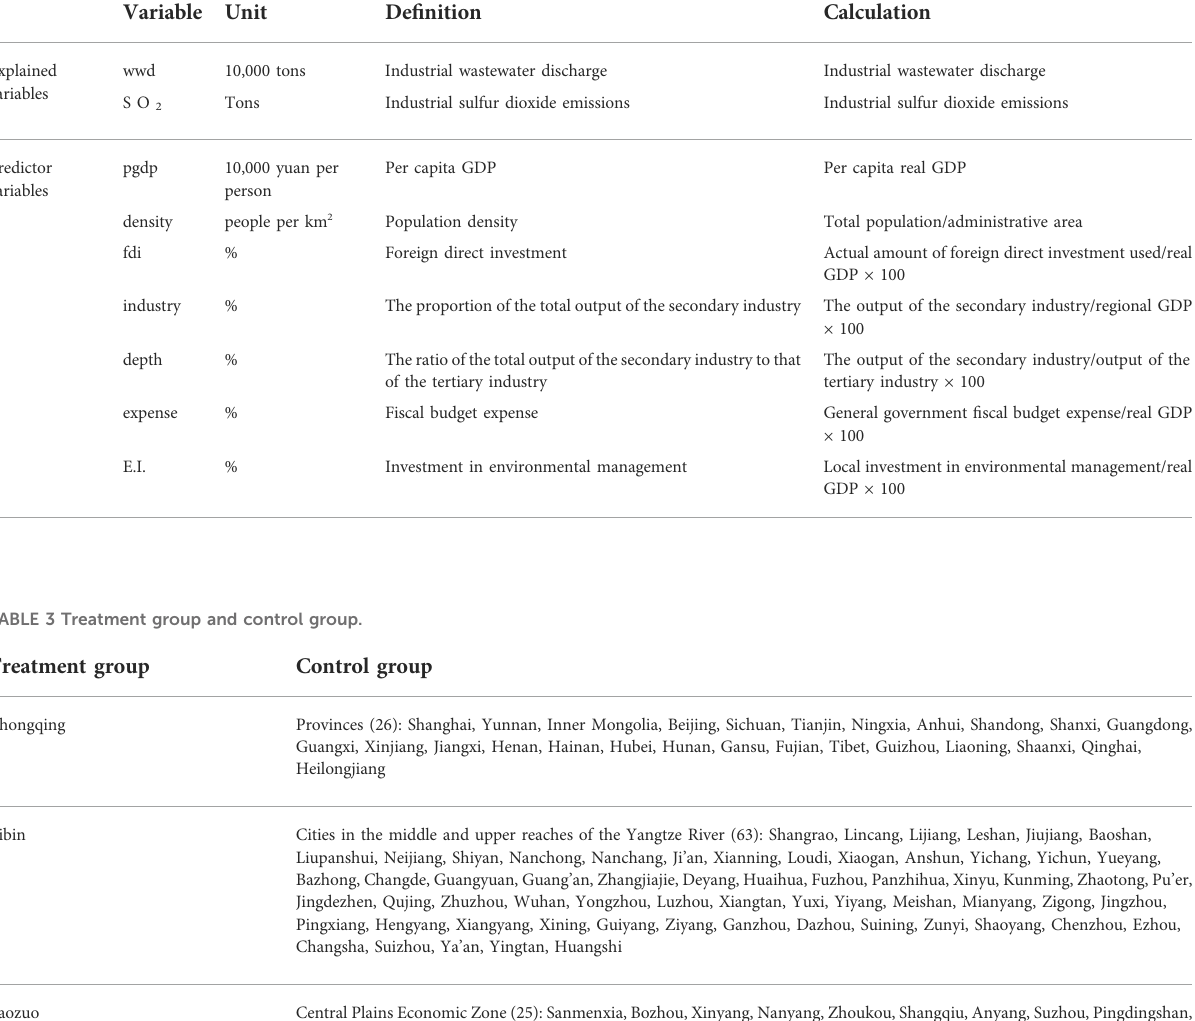
TABLE 2 Variable descriptions.